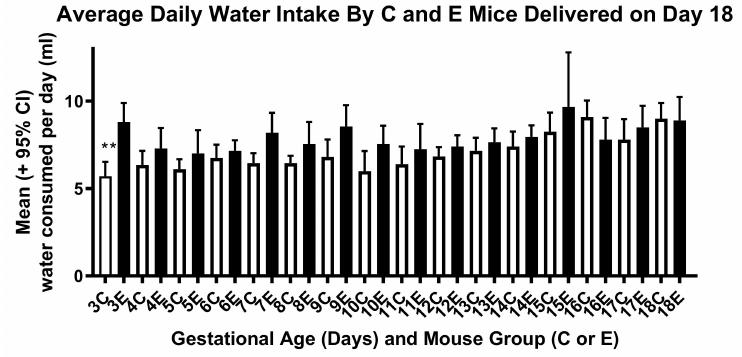
Figure 6. Daily water intake of the control (C) and experimental (E) mice that delivered on day 18 of pregnancy. The di ff erence between the two groups is statistically significant only on day 3 (t-test, p < 0.001). Double asterisks (**) indicate mean values that are significantly di ff erent from each other (control mice, n = 10 dams; experimental mice, n = 10 dams). The number of mice is higher in Figure 4 for experimental mice because water intake was measured reliably in only 10 mice, and the number is lower for control mice in Figure 4 because one mouse delivered on day 18, before dissection could occur.